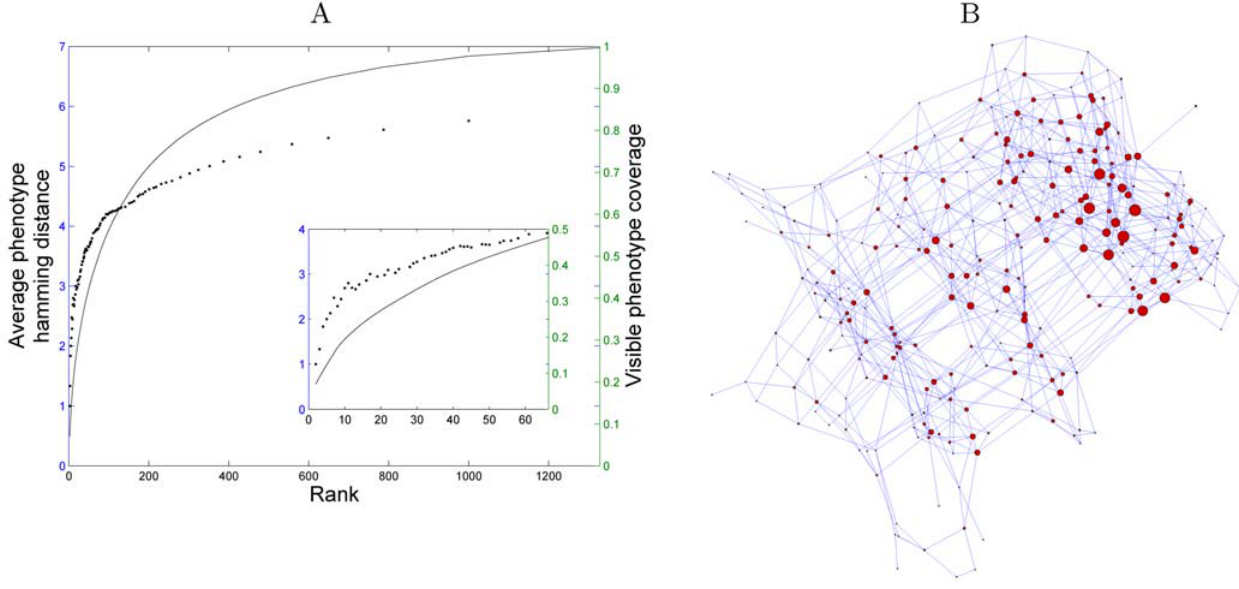
Figure 4. The average distance between the the most frequent phenotypes and the patchiness of the visible phenotypic subspace. (A) The average Hamming distance among visible phenotypes as a function of their frequency (dots). Visible phenotypes are ranked according to their frequency level. For each rank, we calculate the average Hamming distance between all visible phenotypes with this or higher rank. The most abundant phenotypes are very similar. This similarity decreases as less frequent phenotypes are included in the analysis. We also calculate which fraction of all visible phenotypes are included in these phenotypes (solid line). The inset shows a zoom of the same plot, focusing only on the top 5% most frequent phenotypes. The phenotypes that are included in this small fraction of the distinct visible phenotypes, are, on average, only 4 bits different, and still cover 50% of the phenotypes. (B) The one mutant neighbor network of the visible phenotypes. The size of the node is proportional to the logarithm of its frequency. In this plot, r = k =12.